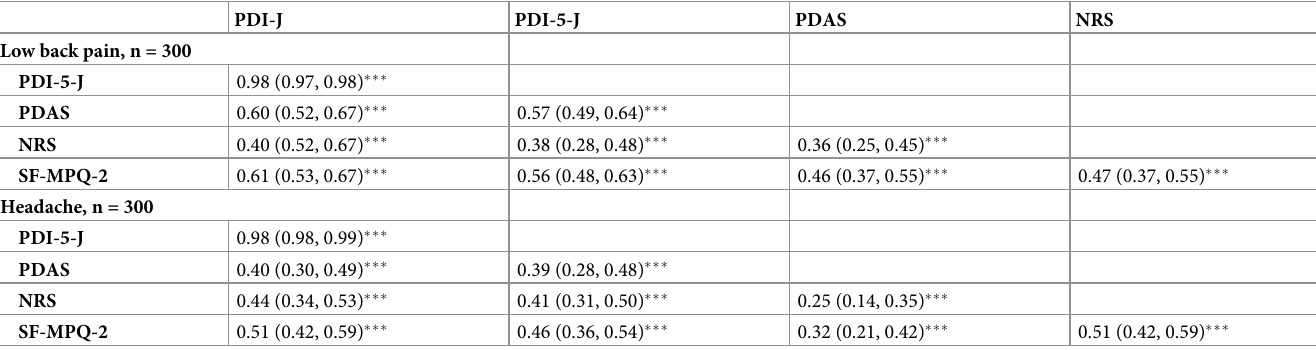
Table 3. Pearson’s correlations coefficient (95% confidence interval). PDI-J